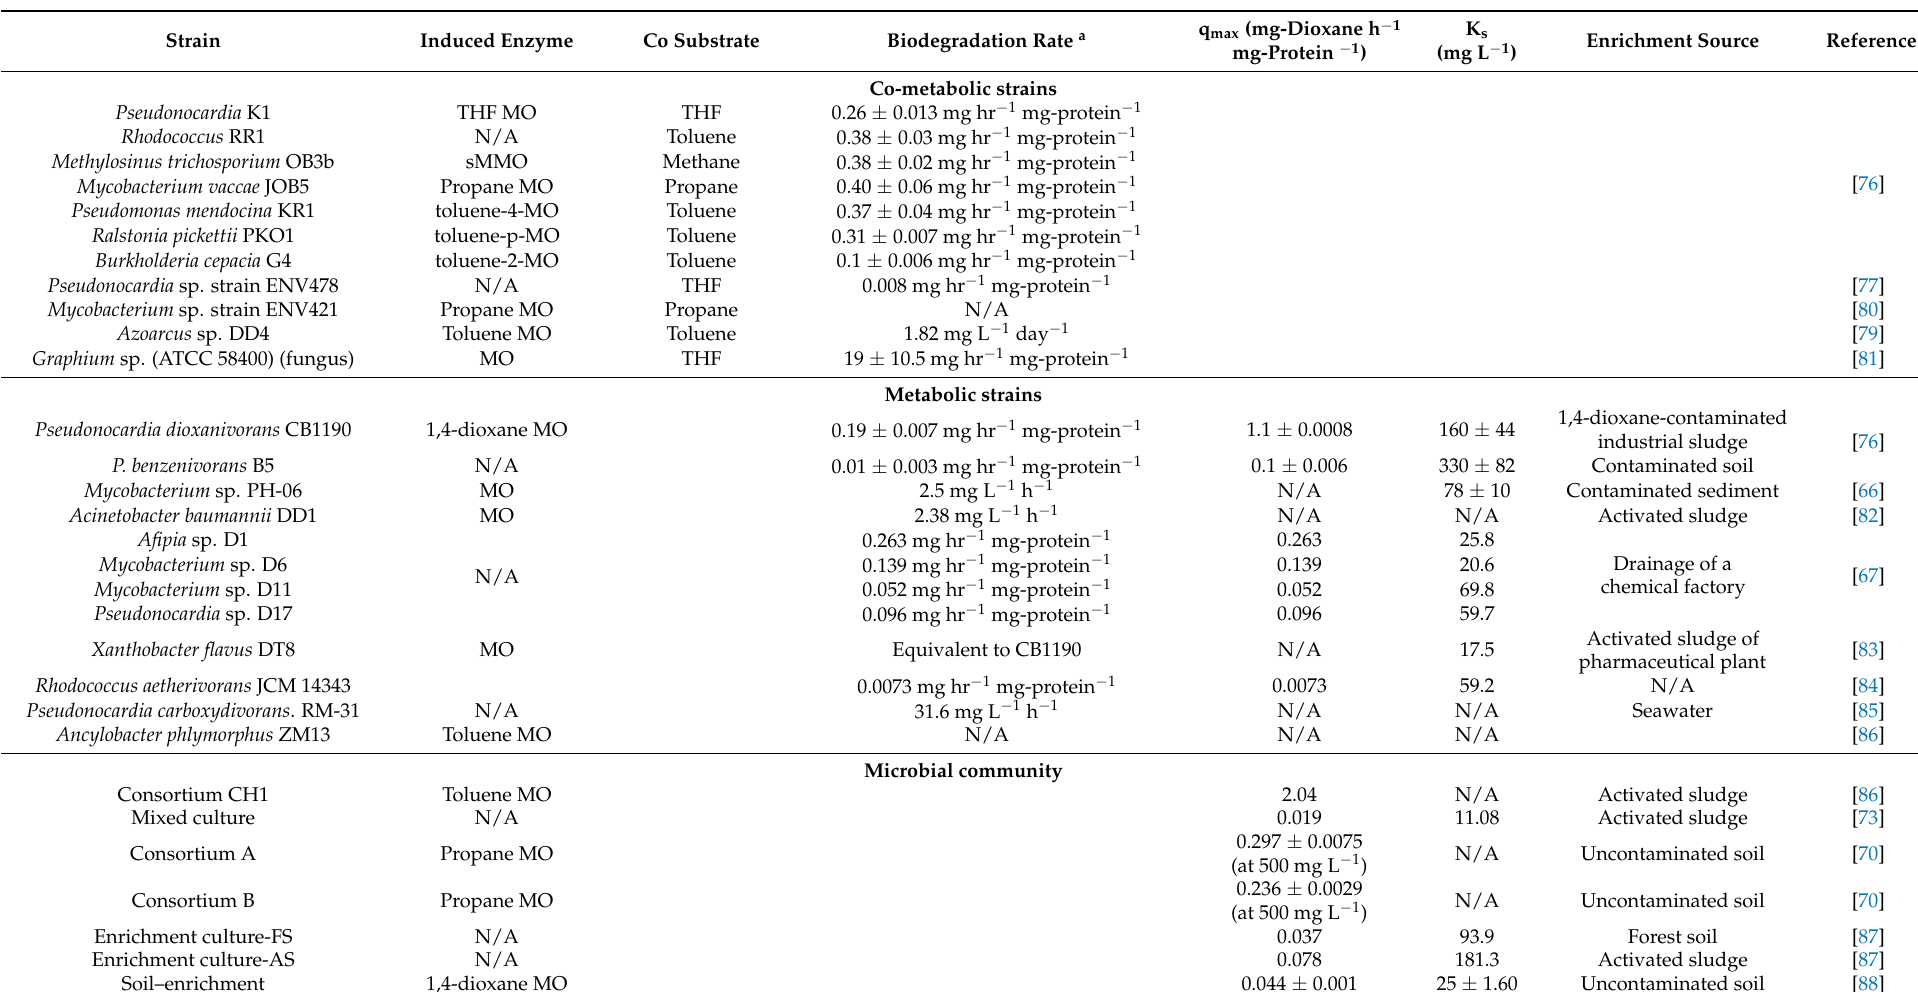
Table 3. Pure strains and microbial communities that can degrade 1,4-dioxane via metabolism or